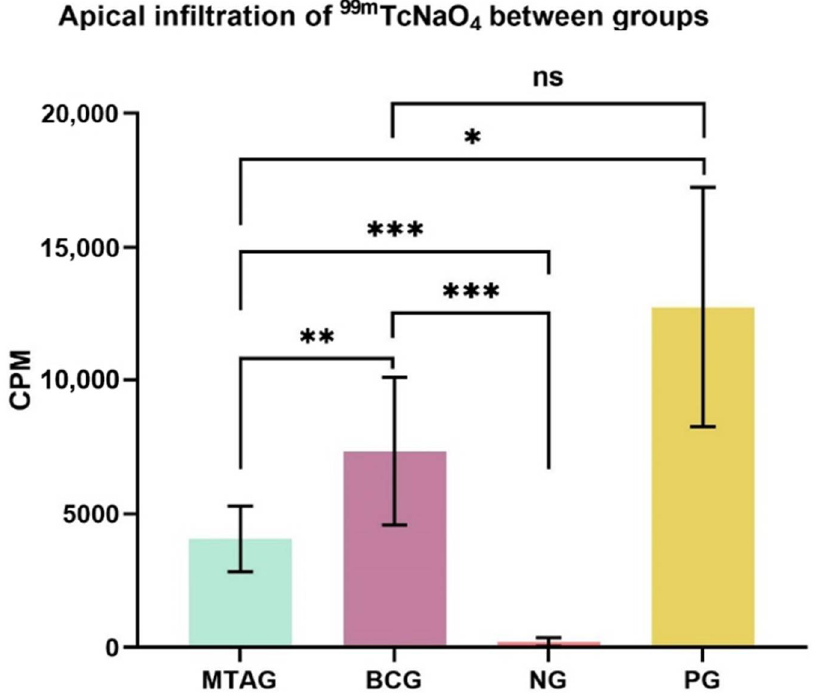
Figure 3. Visual representation of the mean values and standard deviation of the total counts in each group and level of significance between groups: * p < 0.05; ** p < 0.01; *** p < 0.001; ns—no signifi- cance. MTAG: MTA group; BCG: TotalFill Fast Set Putty group; NG: negative group; PG: positive group; CPM: counts per minute.